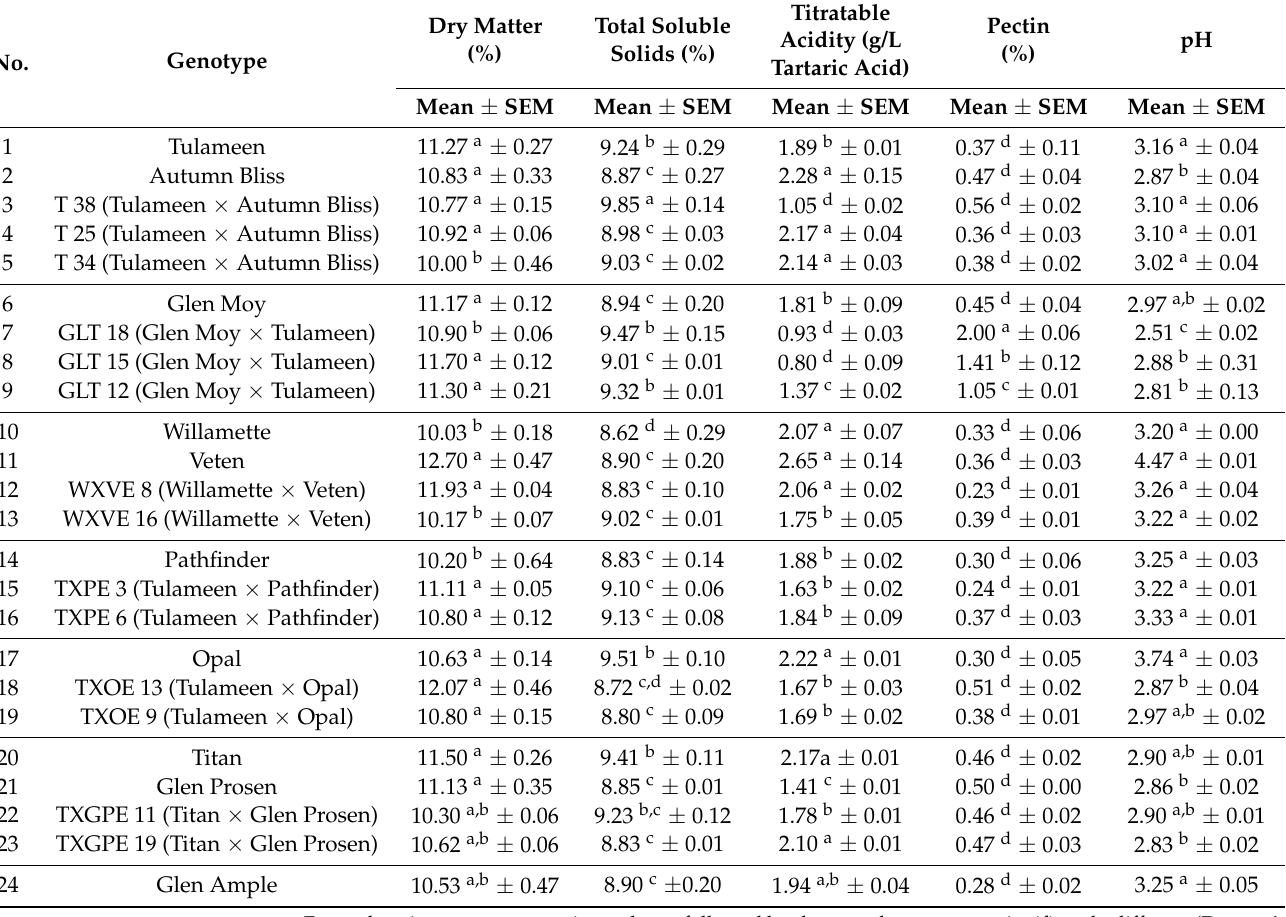
Table 3. The average values for different chemical compounds and pH in the fruits of 24 raspberry genotypes (14 promising selections (clones), their parents, and Glen Ample cultivar as control).